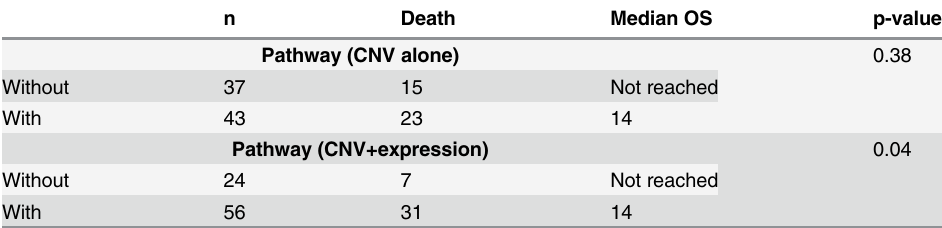
Table 8. Association between genomic events in RB pathway (CNV with or without overexpression) and OS using 10%